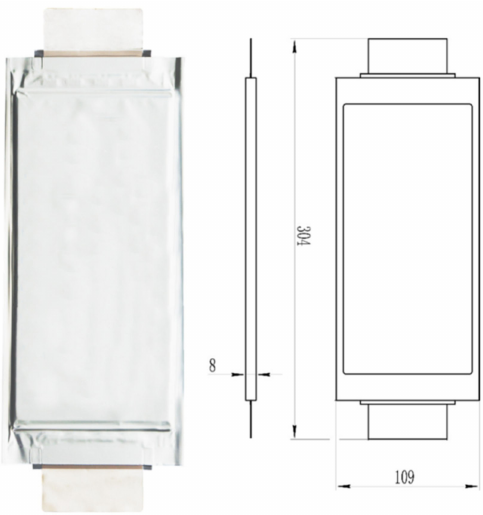
Figure 1. As-prepared LIC